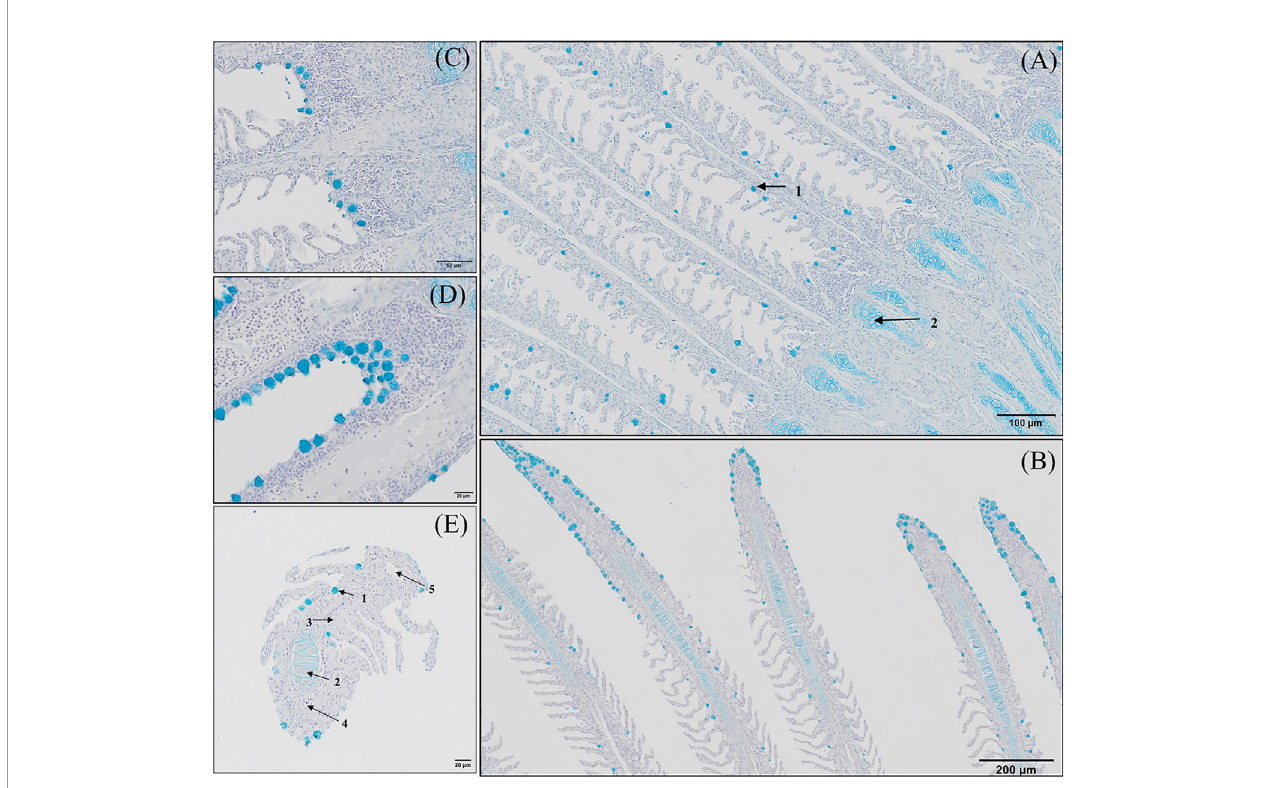
FIGURE 5 | Goblet cells distribution along the gill of European sea bass ( Dicentrarchus labrax ). (A-D) Longitudinal section corresponding to the central segment of the second right holobranch goblet cells distribution along the primary lamella (Alcian Blue pH = 2.5). Observe how primary lamella goblet cells are mainly located between secondary lamellae ( A ; Bar = 100 μm) and in higher density surrounding the top region of the primary lamella ( B ; Bar = 300 μm). Observe the increased density of goblet cells between basal regions of the primary lamellae in contact with the interbranchial gill associated lymphoid tissue ( C , D ; Bar = 50 & 20 μm). (E) Transversal section corresponding to the central segment of the second right holobranch goblet cells